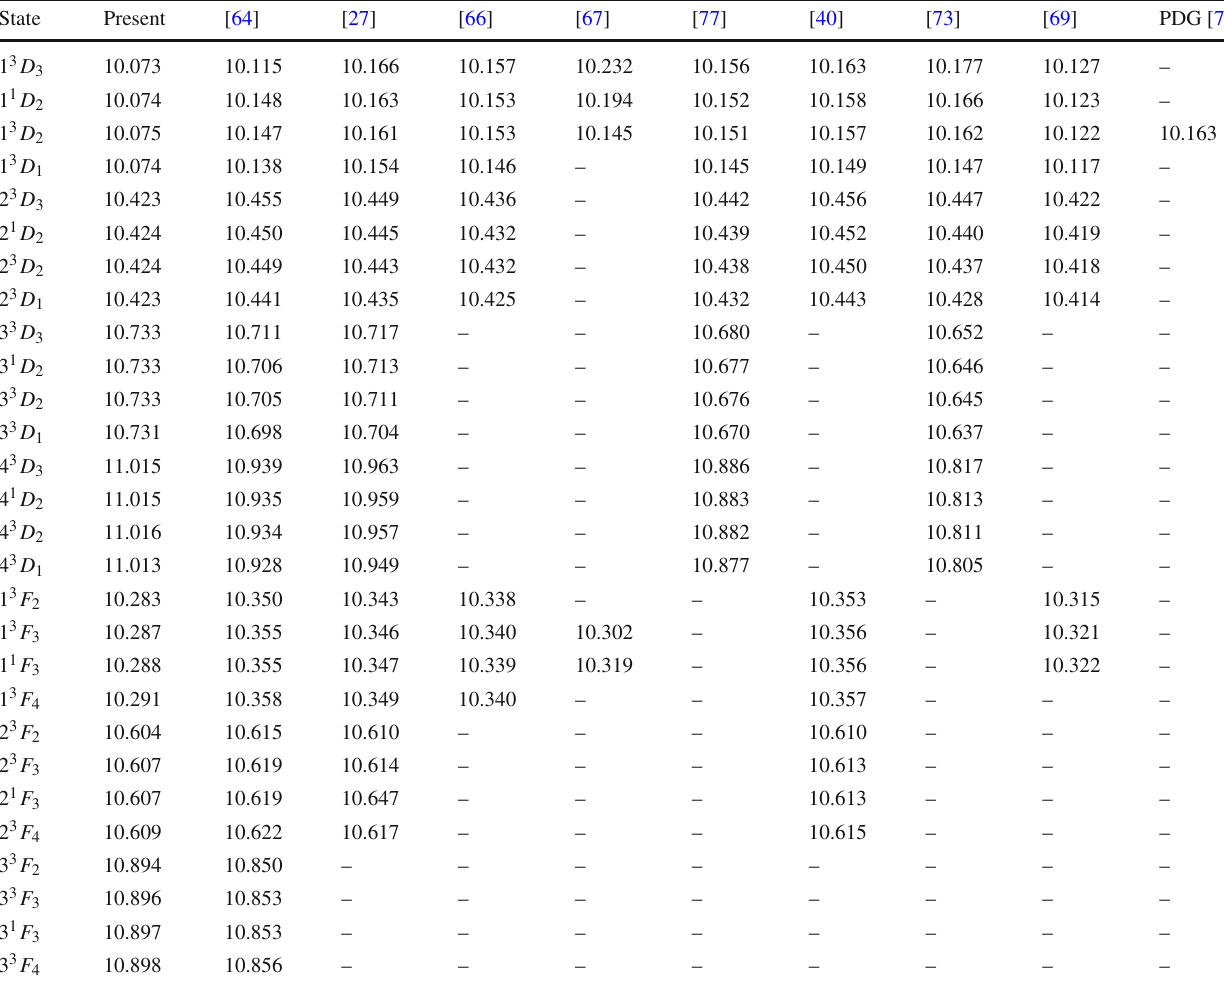
Table 5 Mass spectrum of D and F -wave bottomonia (in GeV) State